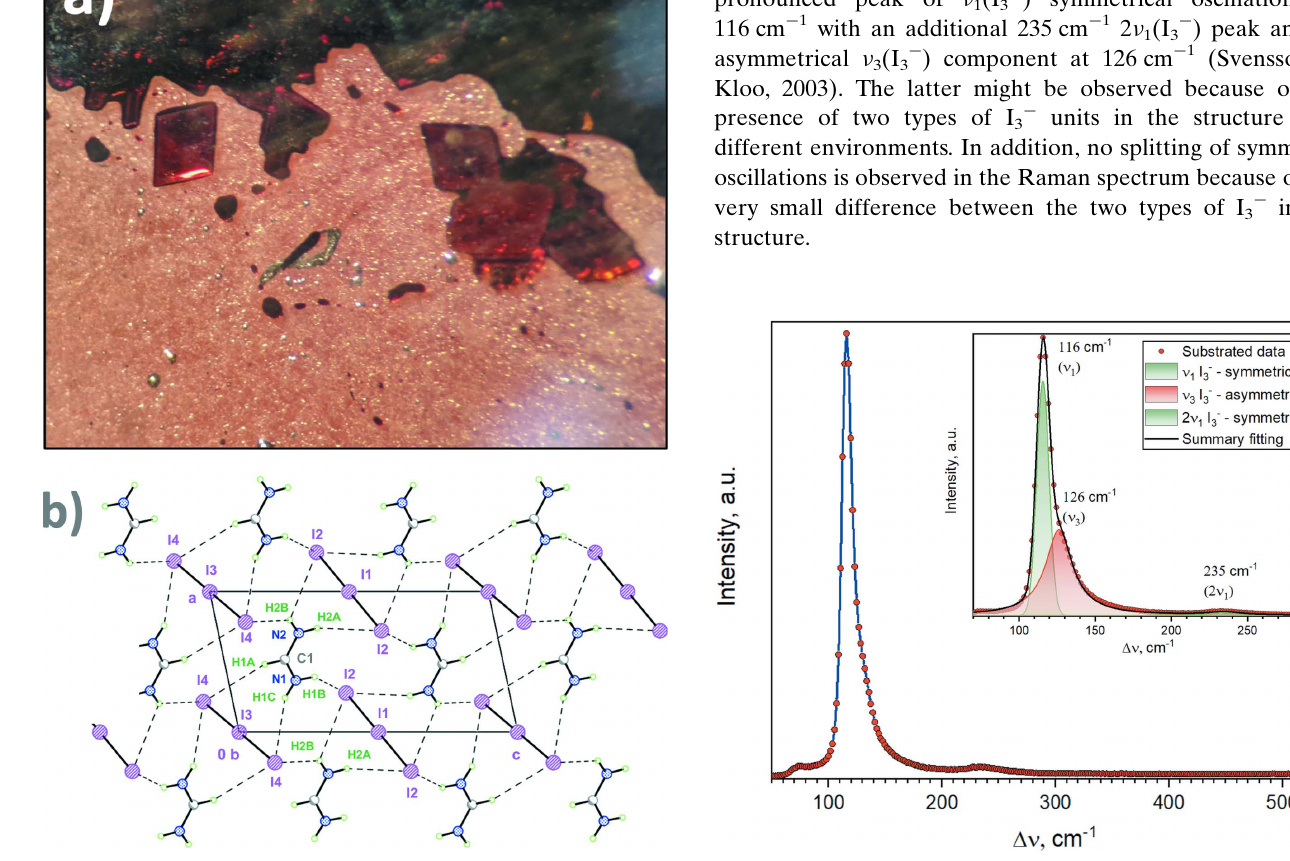
Figure 2 Raman spectrum of a transparent single crystalline plate of FAI 3 . Laser wavelength, 633 nm; laser power, 20 mW; accumulation time, 1 min. The insert demonstrates the results of spectroscopic analysis.